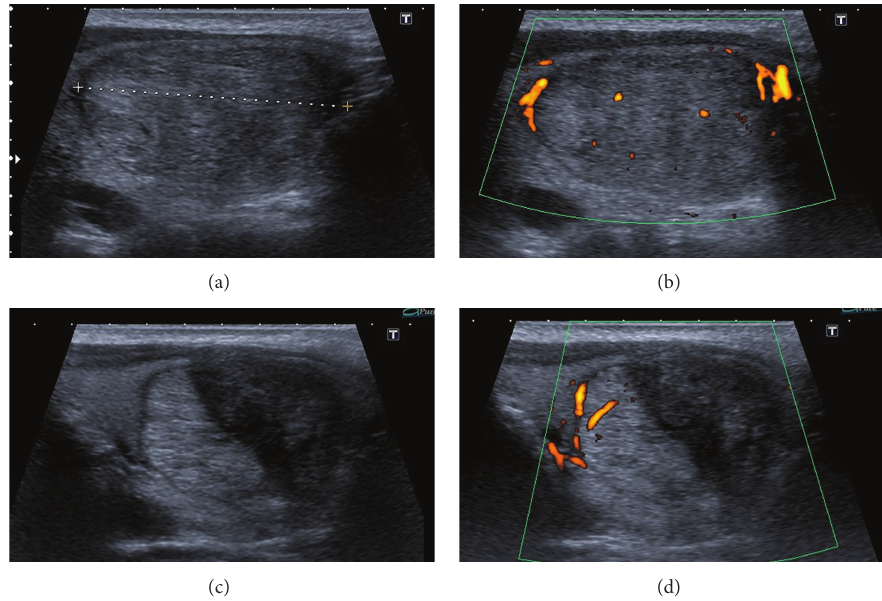
Figure 2: Longitudinal B-mode and power Doppler US images, obtained before (a-b) and after RFA (c-d), show the effects of the procedure at 1 month. The danger triangle, which remains undertreated, is clearly visible on the medial side of the nodule (c-d). Apart from the overall reduction in size, the treated area of the nodule appears hypoechoic and avascular (c-d).